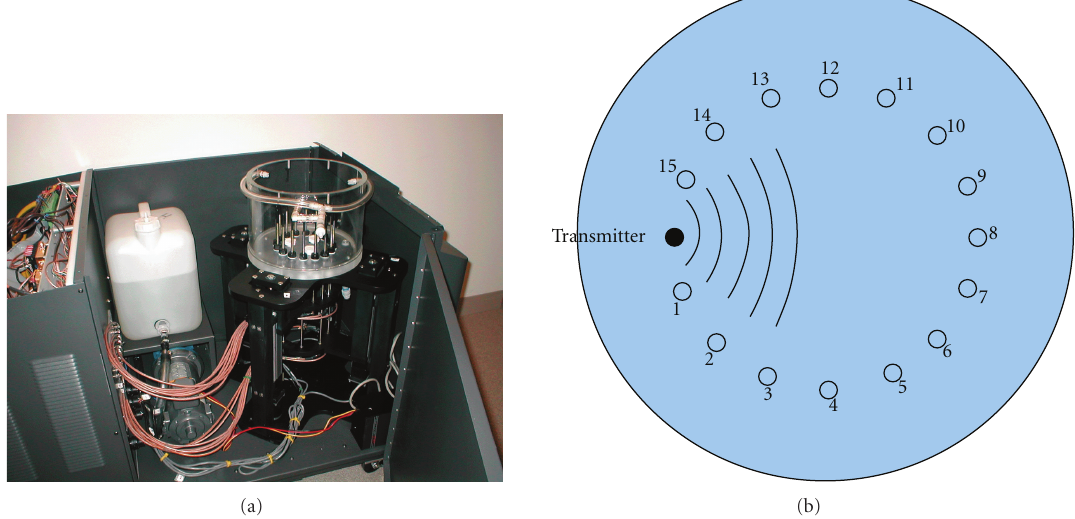
Figure 2: (a) Photograph of the inside of the clinical imaging system showing the imaging tank, liquid reservoir, and antenna motion system. The microwave electronics are housed behind the firewall to the left; (b) schematic diagram of the antenna array configuration.